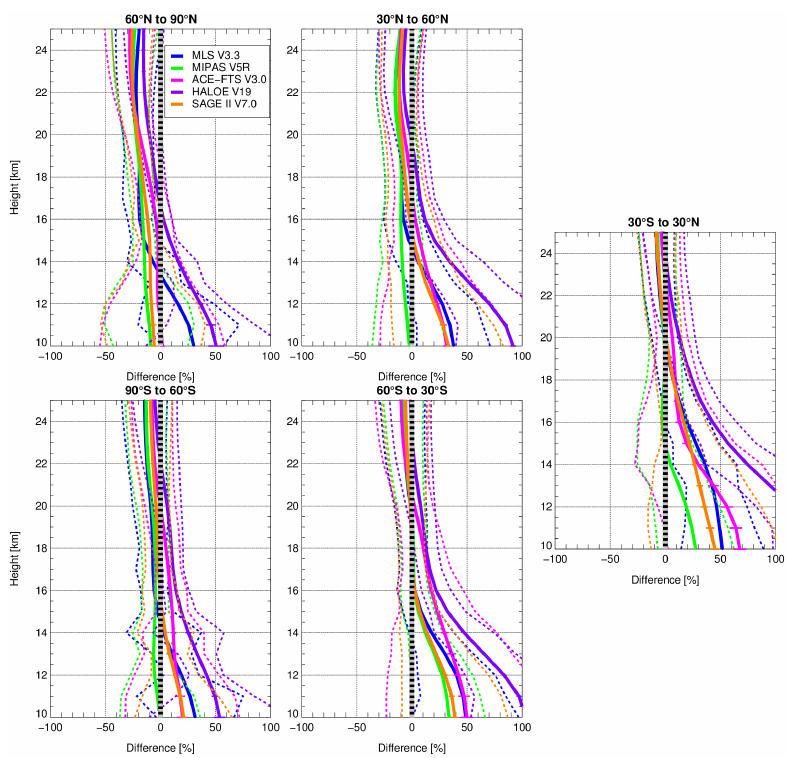
Figure 16. Mean percentage difference between SCIAMACHY and other satellite water vapour profiles smoothed with the AVK of SCIA- MACHY in each panel. The dotted lines show the standard deviation, the error bars (if visible) of the SEM. The panels show different latitude